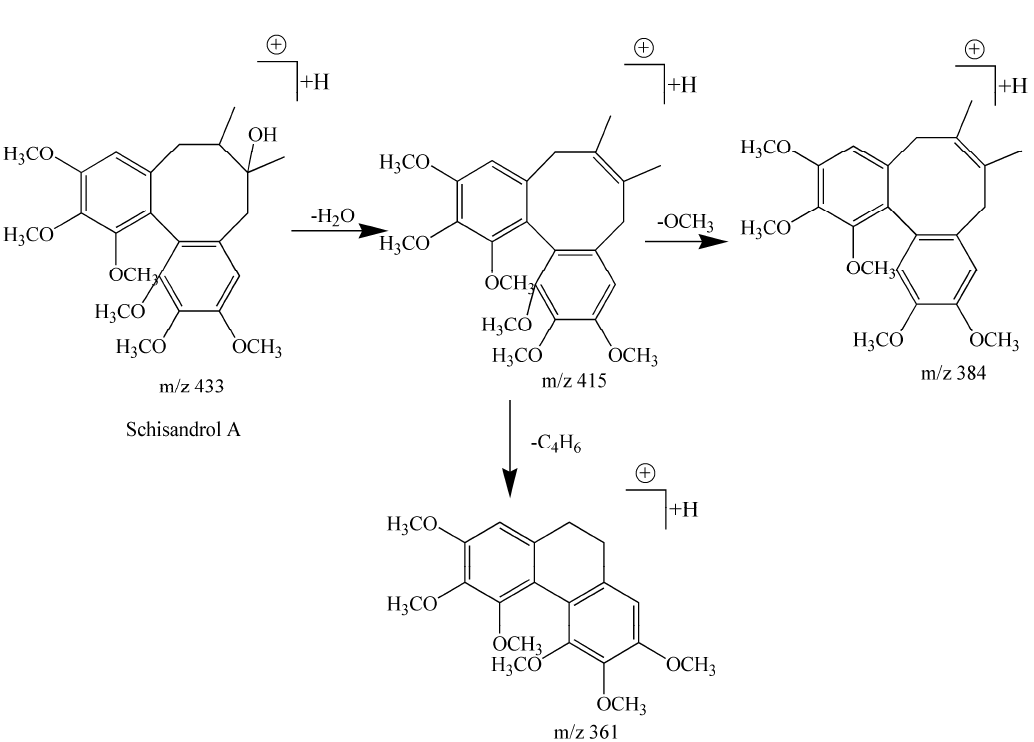
Figure 3. The fragmentation pathways of schisandrol A in positive ion mode.